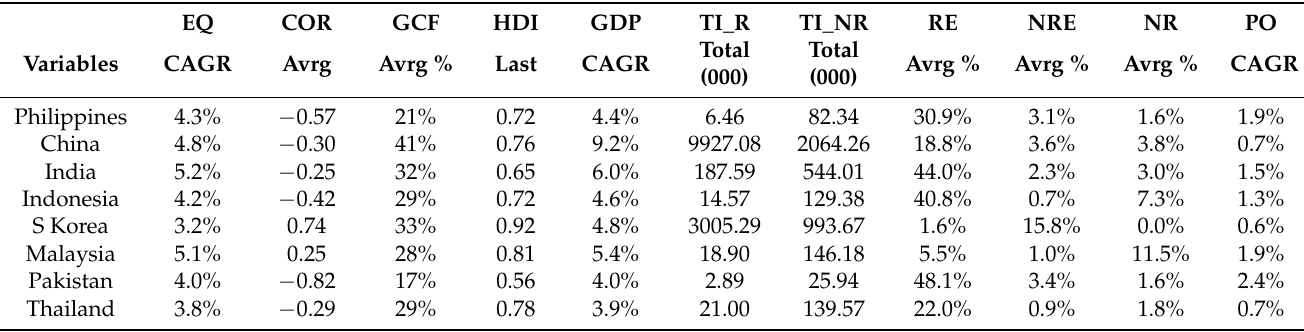
Table 6. Selected